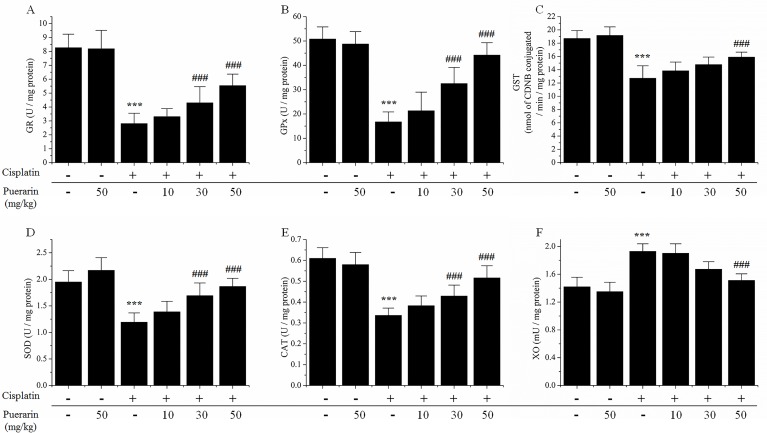
Effects of puerarin on changes of oxidative biomarkers in kidney tissues of cisplatin-treated rats.(A) glutathione reductase (GR) activities; (B) glutathione peroxidase (GPx) activities; (C) glutathione-S-transferase (GST) activities; (D) superoxide dismutase (SOD)activities; (E) catalase (CAT) activities; (F) xanthine oxidase (XO) activities. ***P<0.05 versus control group; ###P<0.05 versus cisplatin alone treated group.